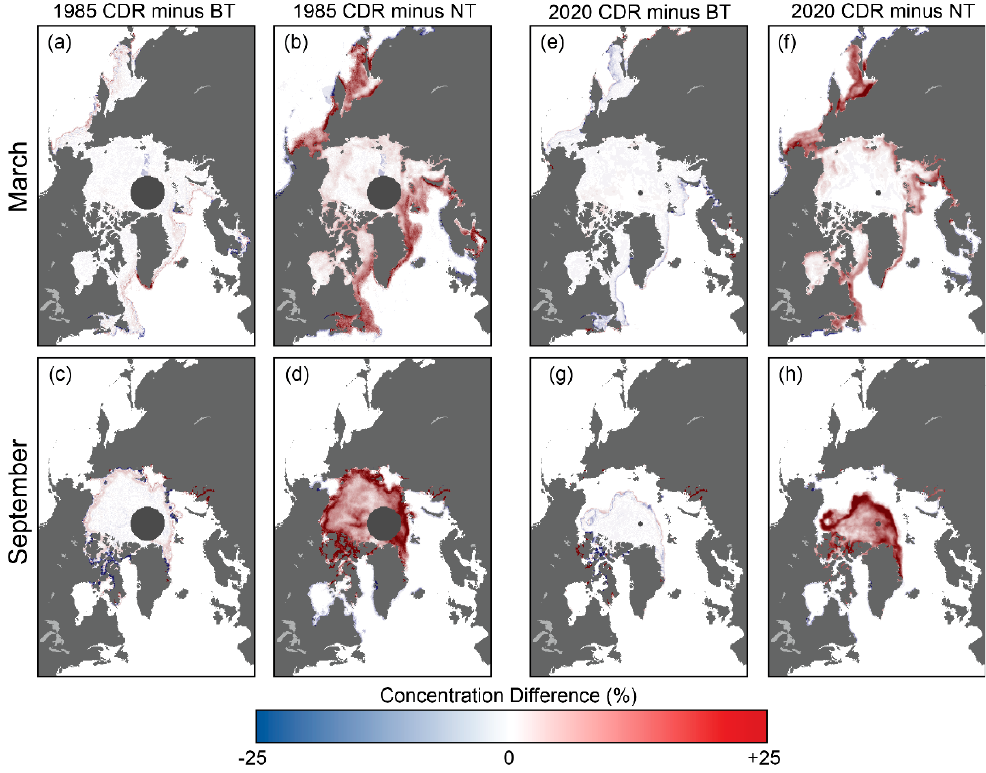
Figure 1. Northern Hemisphere sea ice concentration difference between CDR and the BT and NT algorithm products for March and September for two example years, 1985 ( a – d ) and 2020 ( e – h ).